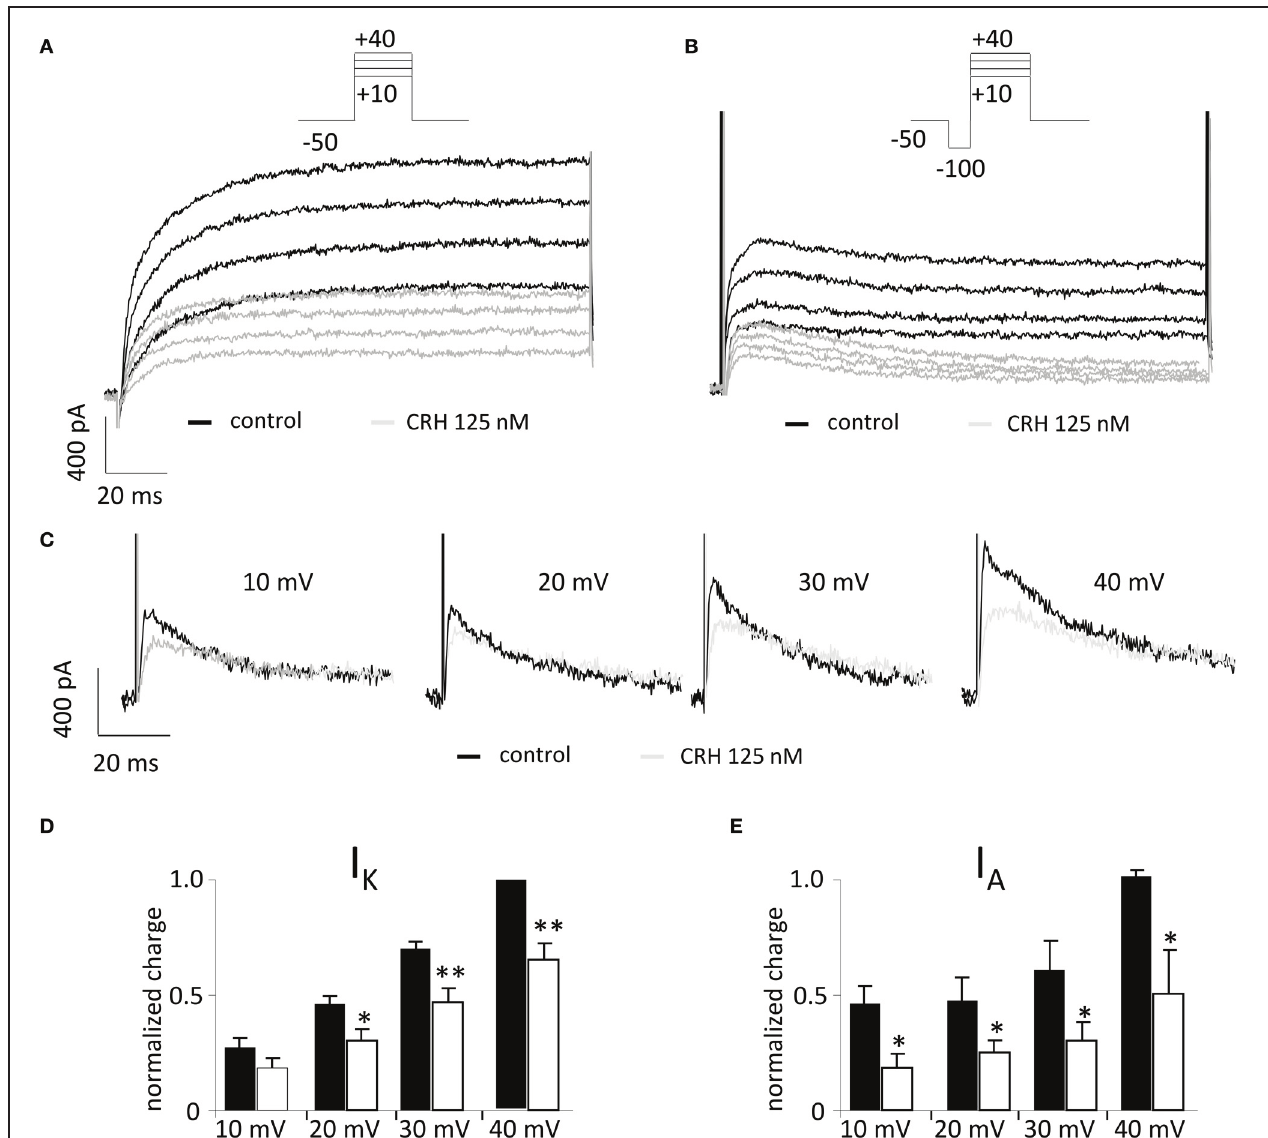
FIGURE 6 | CRH reduces currents through A-type (I A ) and delayed rectifier (I K ) potassium channels. In the voltage clamp mode, currents through voltage gated potassium channels were recorded upon stepwise depolarization of CA1 pyramidal neurons from − 50 to + 40mV ( (cid:3) U = 10mV). (A) Representative recording traces under control conditions (black traces) and in the presence of CRH 125nM (gray traces). (B) A preceding hyperpolarizing step (100ms) de-inactivates fast I A and allows the graphical subtraction of currents with and without the preceding hyperpolarizing step (C) , I A currents